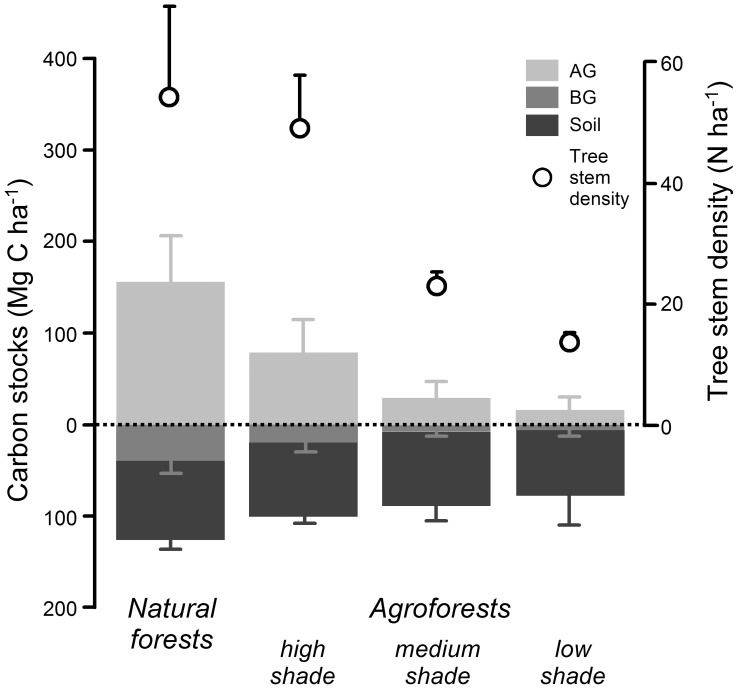
Carbon stocks in natural rainforests and cacao agroforests of varying tree density and shade levels.Shade levels were defined as: high shade: cacao agroforests with diverse, natural shade trees, retained after thinning of the previous forest cover, underplanted with cacao trees and few fruit trees; medium shade: cacao agroforests with shade tree stands dominated by various species of planted fruit and timber trees; low shade: cacao agroforests with a low diversity of planted shade trees, predominantly non-indigenous, nitrogen-fixing leguminous trees and a few native fruit tree species. Columns show mean carbon stocks (+1 SD) in the above-ground (AG) and below-ground (BG) plant components as well as in the soil. Also shown is the mean stem density (+1 SD) of trees with diameters ≥10 cm at breast height.